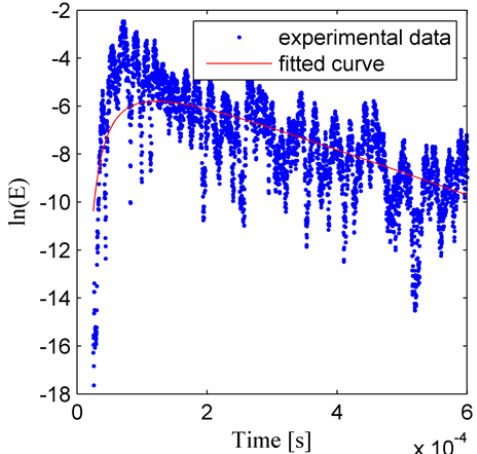
Figure 7. Ultrasonic energy density curve with a tensile force 48 kN.